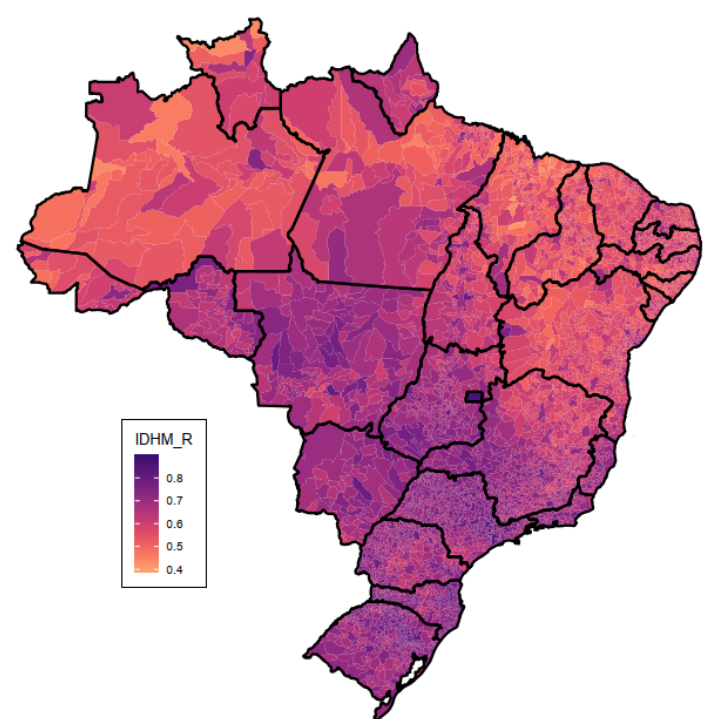
Figure 7. An overview of IDHM_R in Brazil. Source: prepared by the authors.